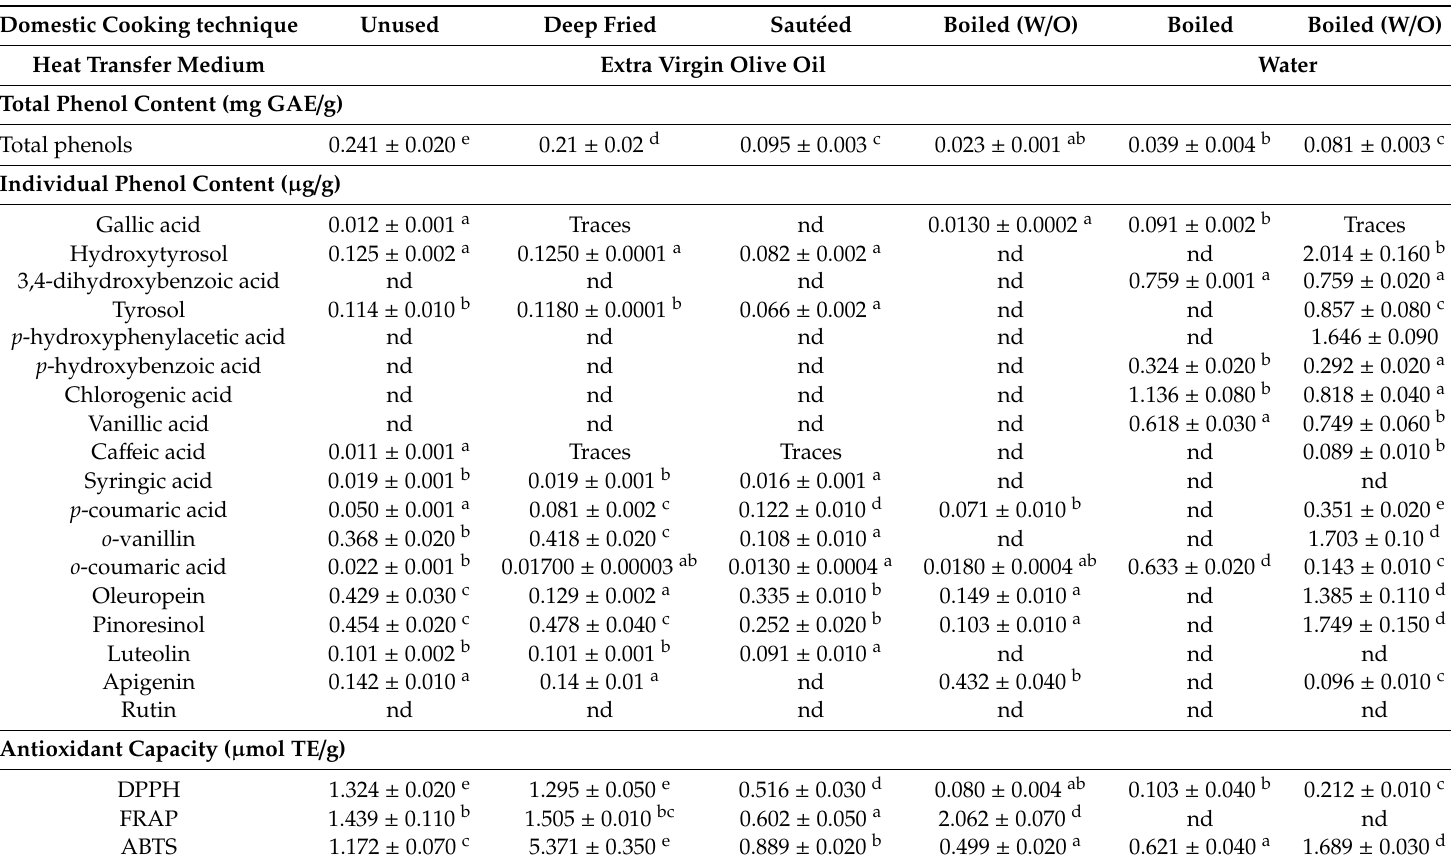
Table 1. Phenolic concentration and antioxidant capacity of extra virgin olive oil (EVOO) and water used during the cooking of potatoes according to four